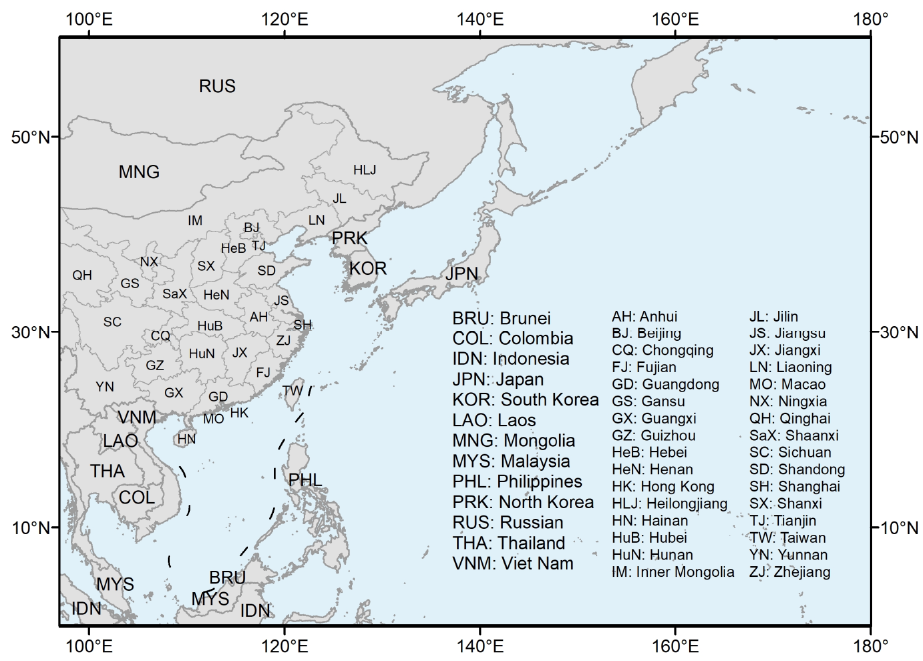
Figure 1. The study region.